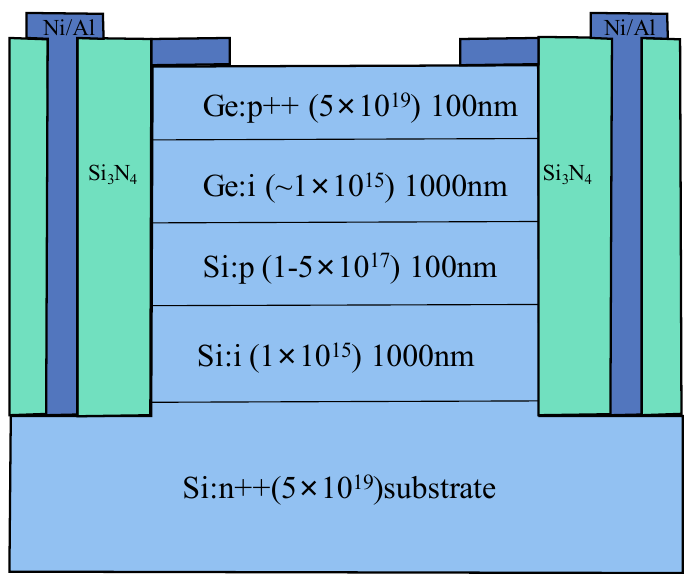
Figure 13. Cross-section schematic of Ge/Si mesa type APD structures (Si 3 N 4 was utilized for passivation and